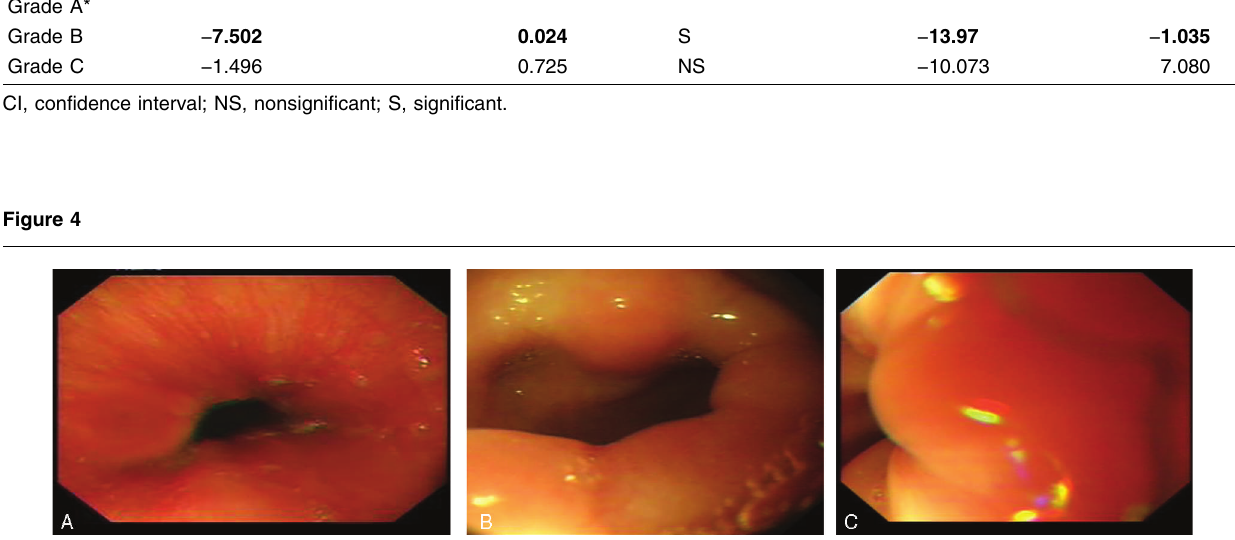
Endoscopic grades of GERD. GERD, gastroesophageal